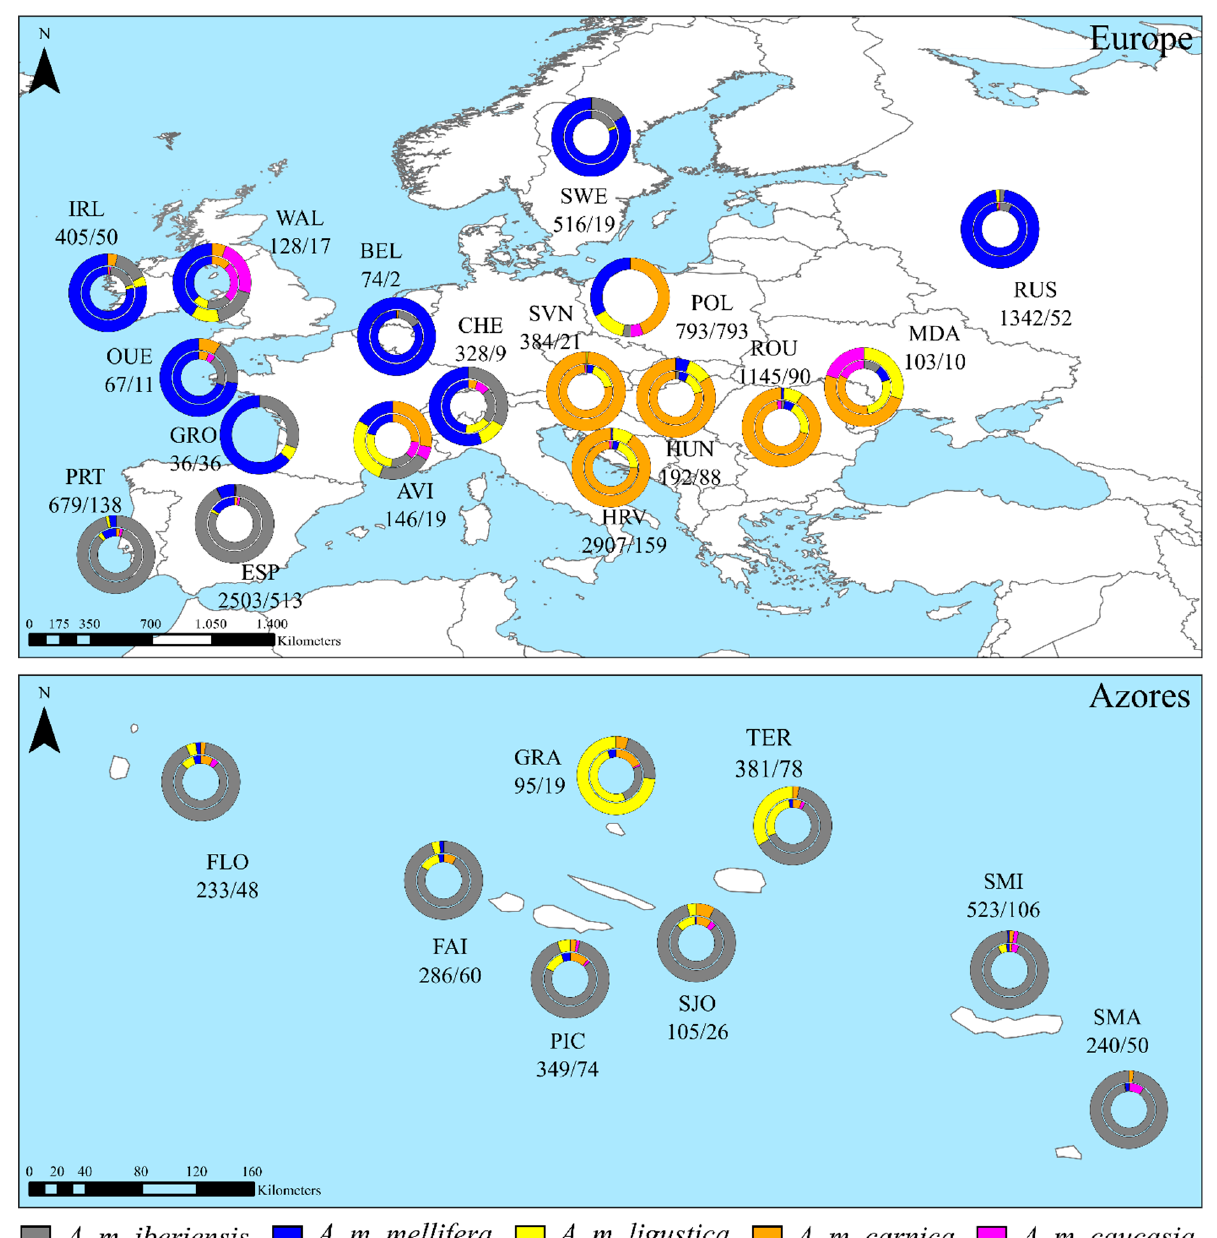
Figure 1. DeepWings© classification at the individual wing and colony levels. Sections in each donut chart represent the proportion of wings (inner ring) or colonies (outer ring) classified into each subspecies. Sample sizes of individual wings/colonies are indicated for each location. In the cases of Groix (France), Poland, and Hungary, each colony is represented by a single wing, so that classification for wings and colonies is coincident. AVI-Avignon, BEL-Belgium, CHE-Switzerland,